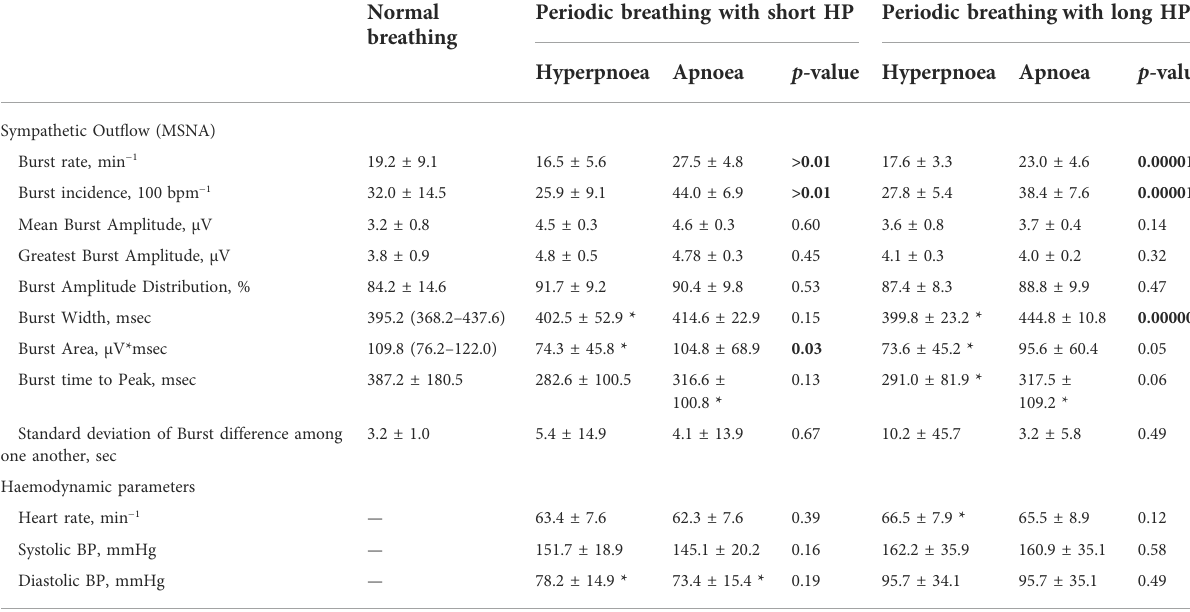
TABLE3Comparisonofsympatheticout fl owandhemodynamicdatabetweencentralapneasandhyperpneaphasesduringperiodicbreathingwitha short and a long hyperpnea length. Normal